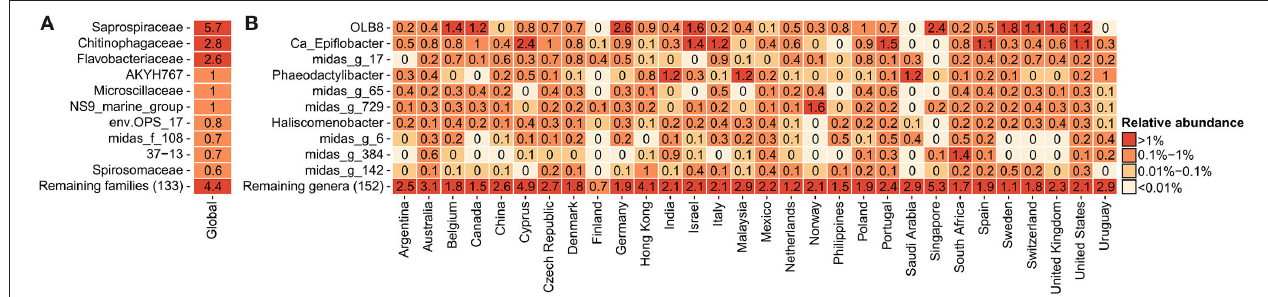
FIGURE 1 | Global average relative read abundance in 929 activated sludge samples: (A) 10 most abundant families within Bacteroidota and (B) 10 most abundant genera within Saprospiraceae